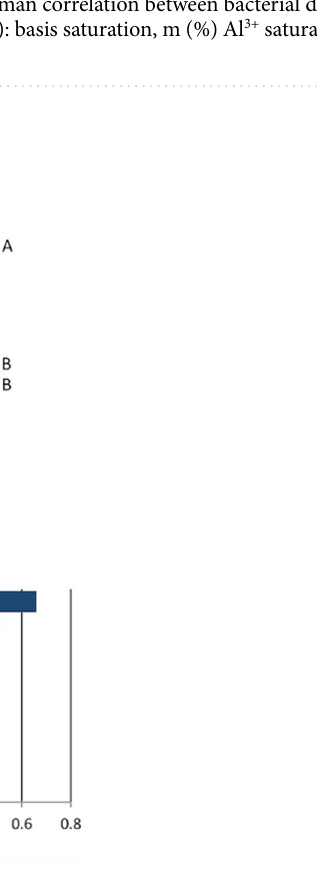
Figure 4. ( A ) Comparison of the cowpea yield between sites. Error bars represent the standard deviation of four independent replicates. The dashed lines represent the average value for each region. Different lower- case letters refer to significant differences between each site and different upper-case letters refer to significant differences between regions. The comparison is based on Tukey’s HSD test using the PAST software ( P < 0.05). ( B ) Correlation between cowpea yield and bacterial phyla. Blue and red bars represent positive and negative correlation, respectively. The correlation is based on Spearman’s rank coefficient (*** P < 0.001, ** P < 0.01, * P <